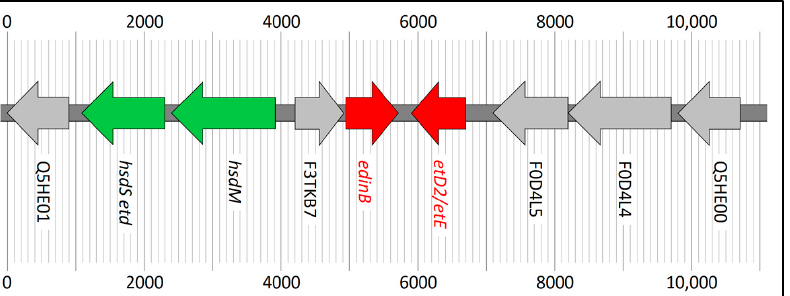
Figure 3. The pathogenicity island with edinB and etD2 / etE as present in ST2990, ST7687, ST7749, ST7750, and CC130 (see also Table 3).